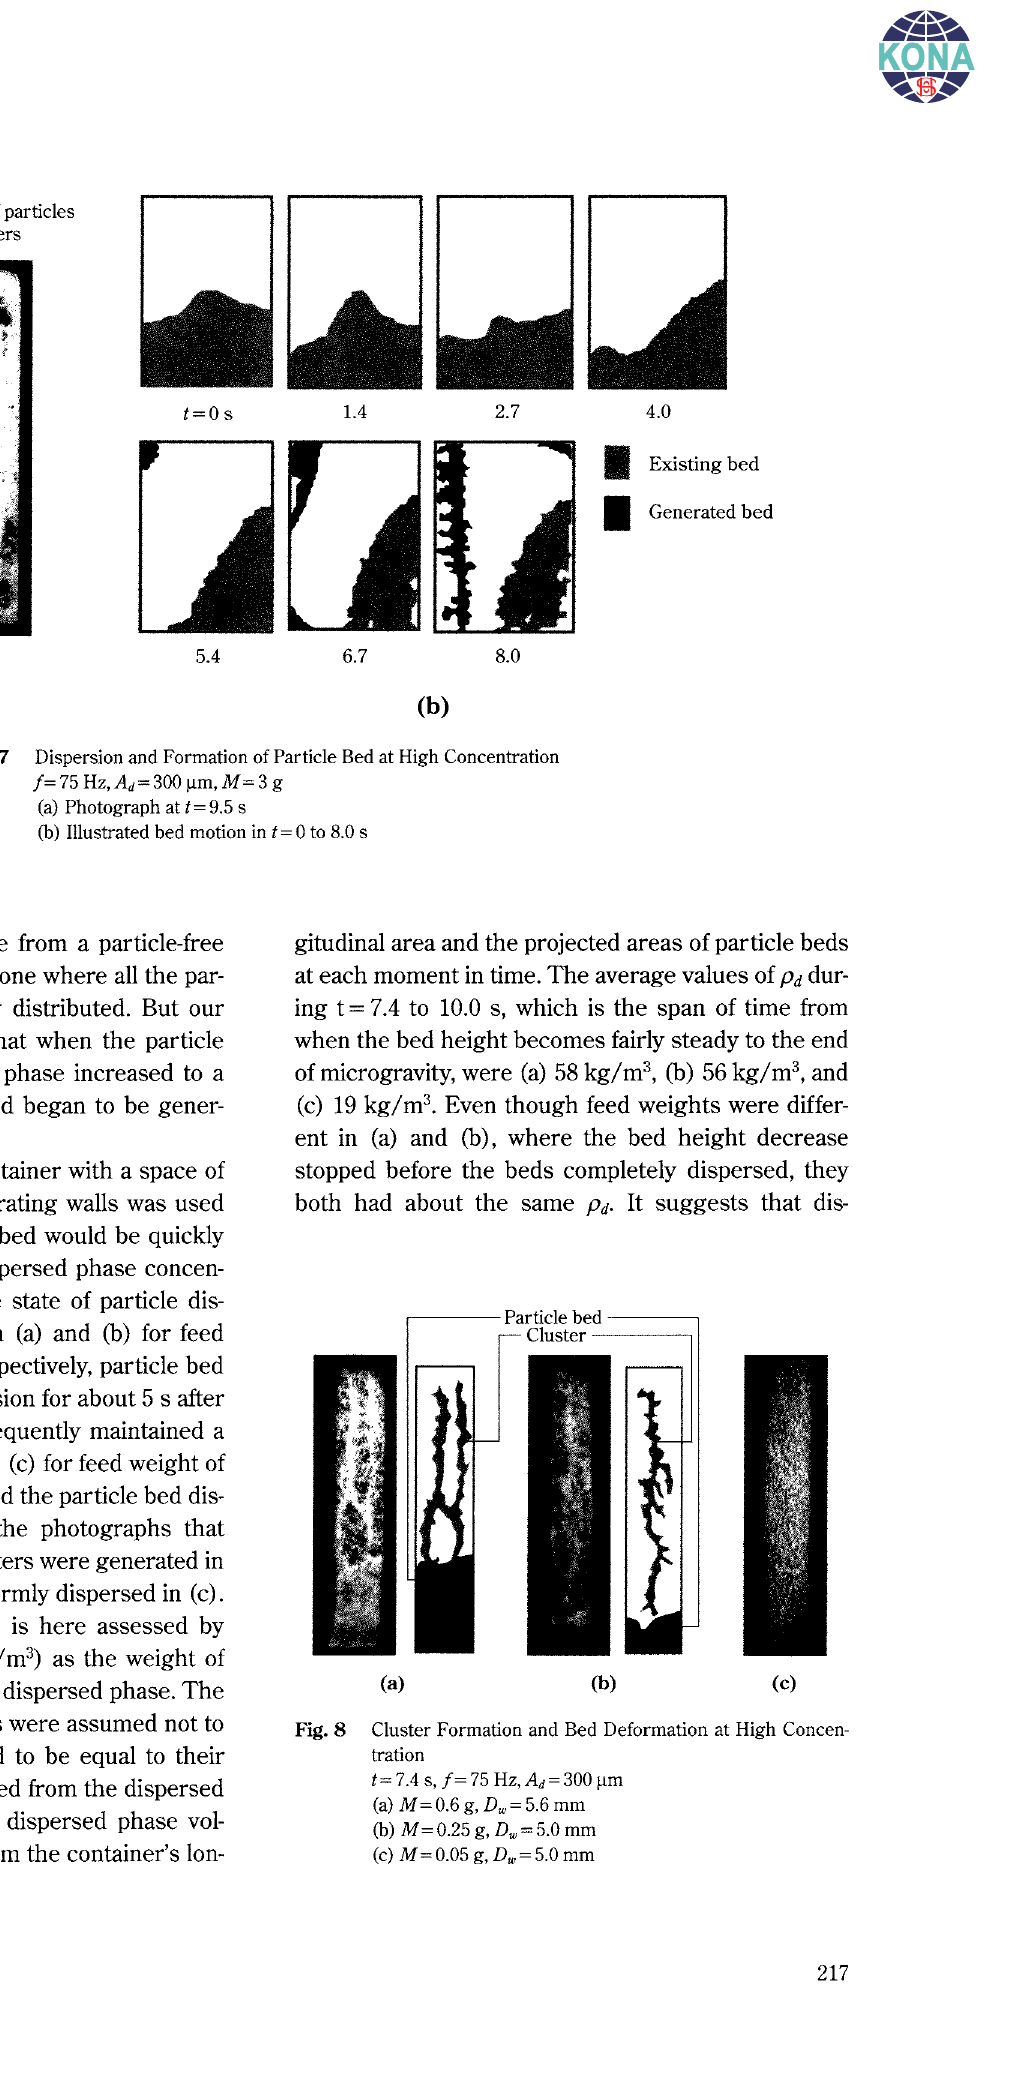
Fig. 8 Cluster Formation and Bed Deformation at High Concen tration t= 7.4 s, /=75 Hz,Ad=300 /lm (a) M=0.6 g, Dw=5.6 mm (b) M=0.25 g, Dw=5.0 mm (c) M = 0.05 g, Dw = 5.0